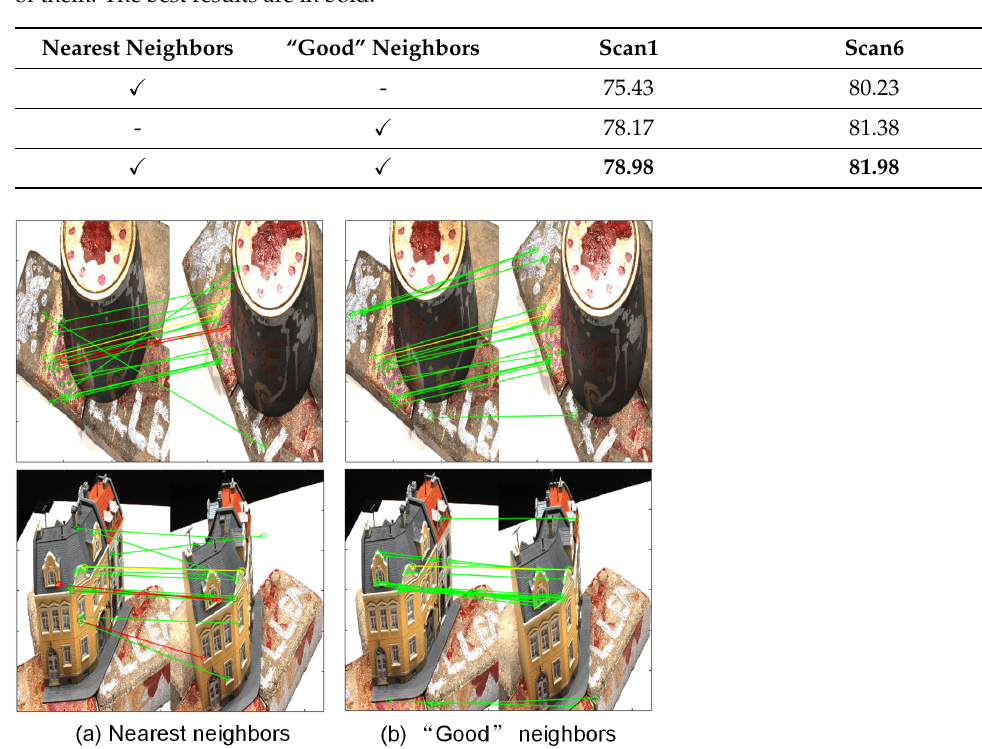
Table 1. Ablation study of the neighbor selection strategy. The average F1-score (%) on the DTU dataset for three settings: using nearest neighbors only, using “good” neighbors only and using both of them. The best results are in bold.